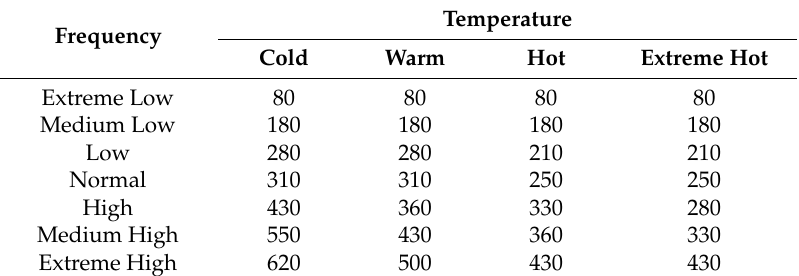
Table 4. Fuzzy rules for I gain ( k i